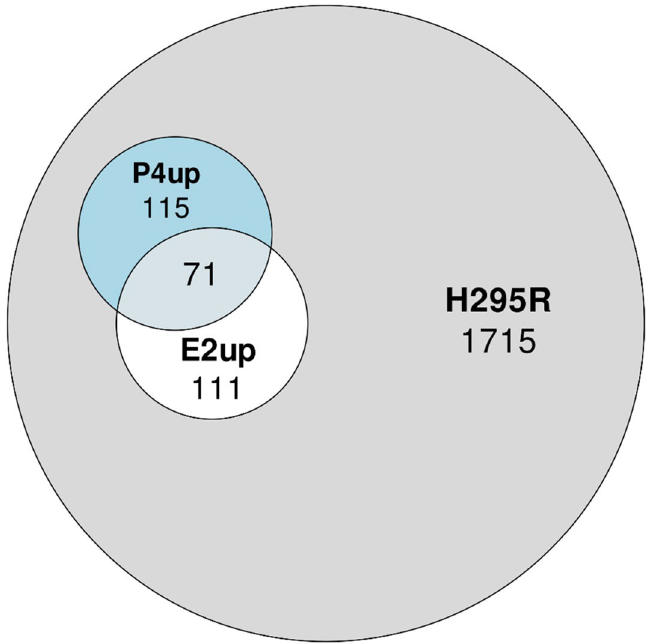
Figure 1. Venn diagram representing the overlap between the active chemical set that increases production of E2 (E2up), the active chemical set that increase production of P4 (P4up) and all chemicals tested in the H295R assay (H295R set).